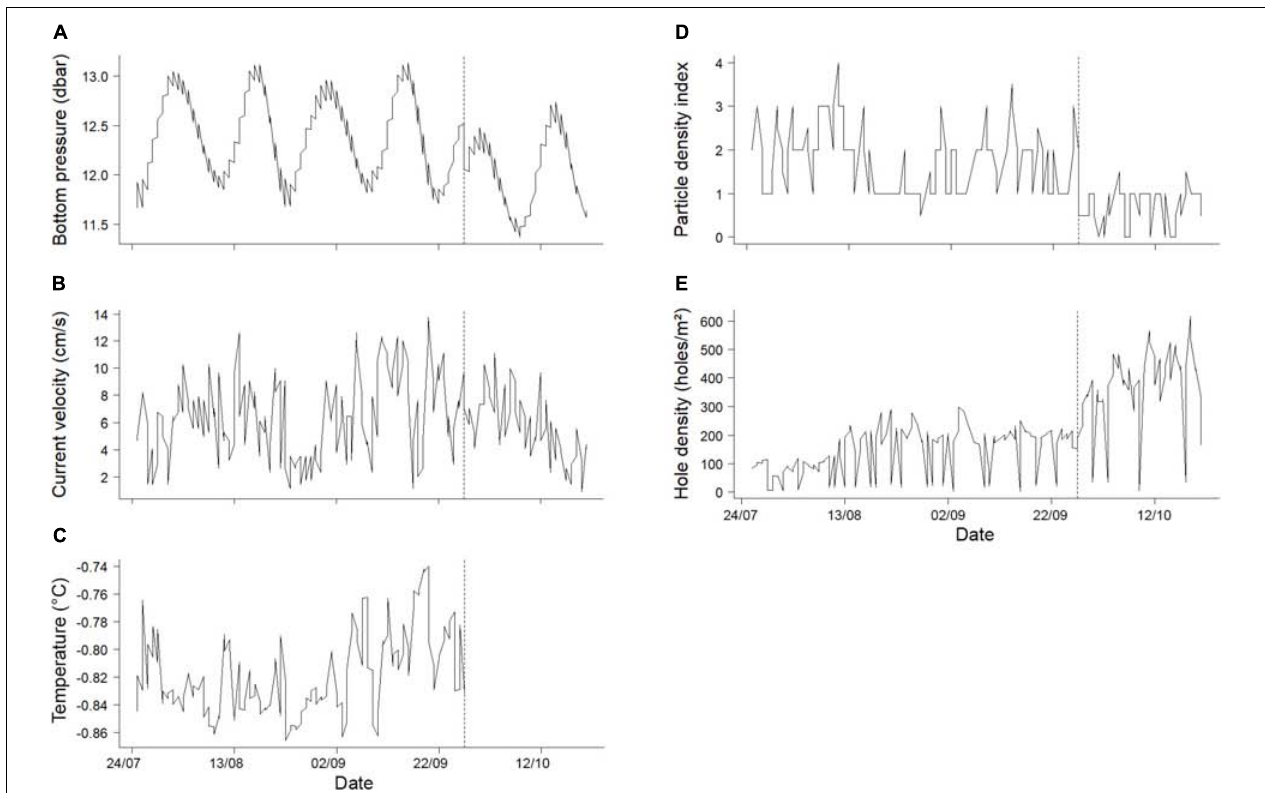
FIGURE 5 | Time series of environmental variables before and after the mud eruption. (A) Bottom pressure (Blandin, 2009), (B) current velocity (Wenzhöfer, 2009) and (C) seabed temperature (Feseker, 2009) were measured by sensors deployed as part of the LOOME observatory. (D) Particle index and (E) hole density were estimated from imagery. The vertical dotted lines indicate the day of the mud eruption. Temperature data collected after the eruption are not shown as they were not considered representative of seabed temperatures at the AIM deployment site (see section “Materials and